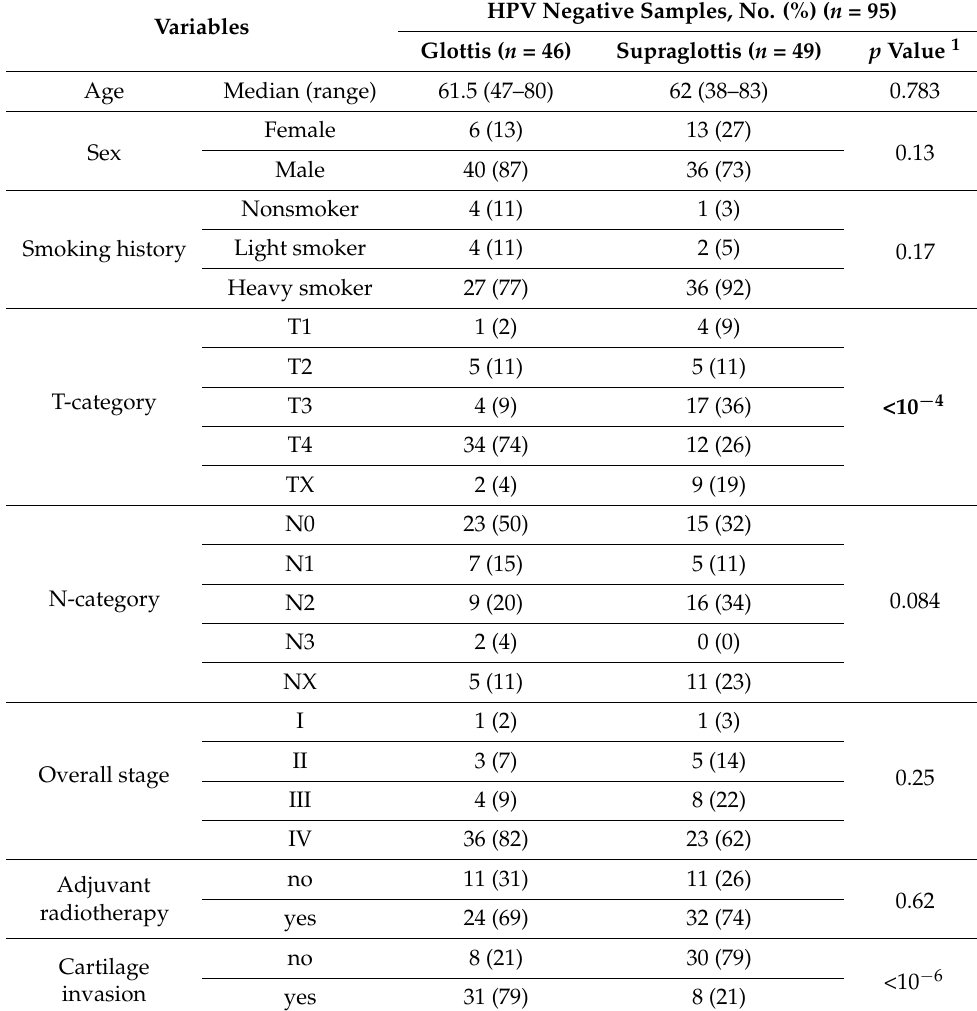
Table 1. Clinical characteristics of the TCGA LSCC cohort by primary subsite of